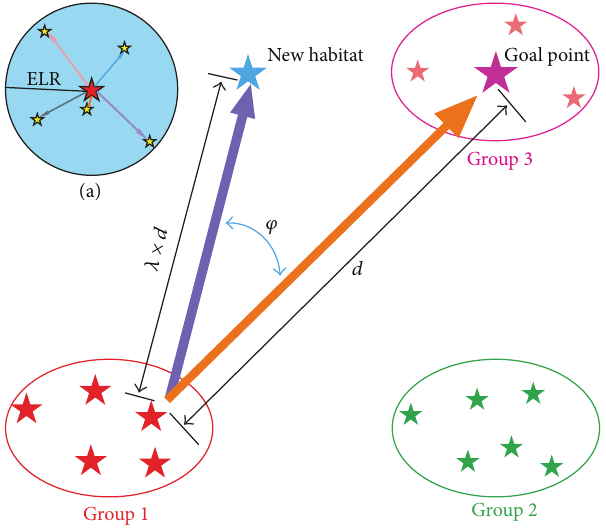
Figure1:RandomegglayinginanELRandimmigrationofasample cuckoo toward a goal